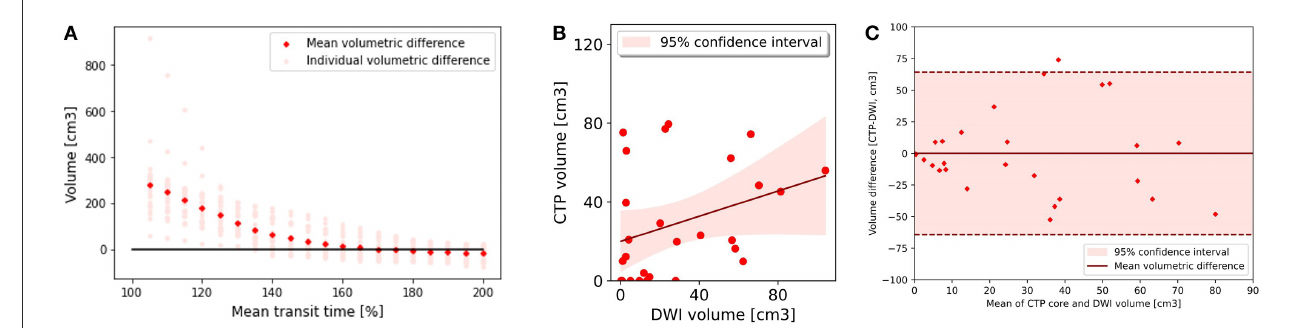
FIGURE3 Core analysis. (A) Mean volumetric difference between follow up diffusion weighted imaging lesion and acute perfusion lesion according to mean transit time threshold. In group 2, the perfusion lesion identified at a MTT of > 170% resulted in the smallest volumetric difference with follow up MRI 0.03 ( − 13.19 to 13.24). (B) CTP lesion volume using Mean transit time > 170% versus 24h DWI lesion volume. There was poor correlation between the acute perfusion lesion and follow up imaging volume ( R 2 = 0.11). (C) Bland-Altman plot demonstrating the volumetric agreement between the perfusion